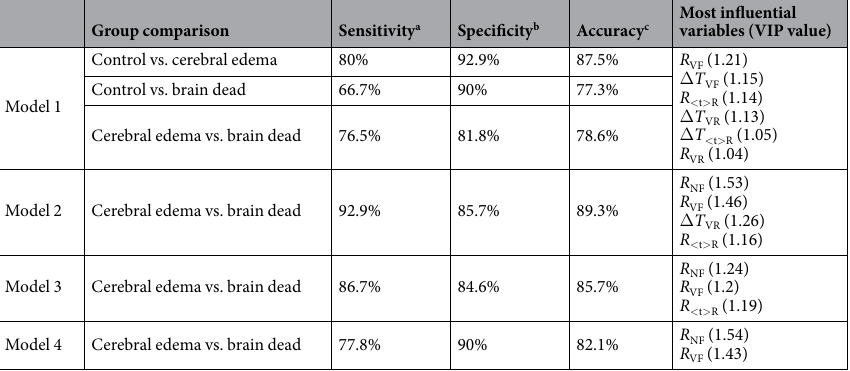
Table 2. Sensitivity, specificity, accuracy, and most influential variables (VIP > 1) of the four analyzed OPLS-DA models. a Proportion of those with the target condition (brain death, or cerebral edema in case of cerebral edema vs. control) who are correctly classified (true positives) using the optical method measurements. b Proportion of those without the target condition who are correctly classified (true negatives) using the optical method measurements. c Accuracy is the proportion of true results (both true positives and true negatives) of the total number of cases